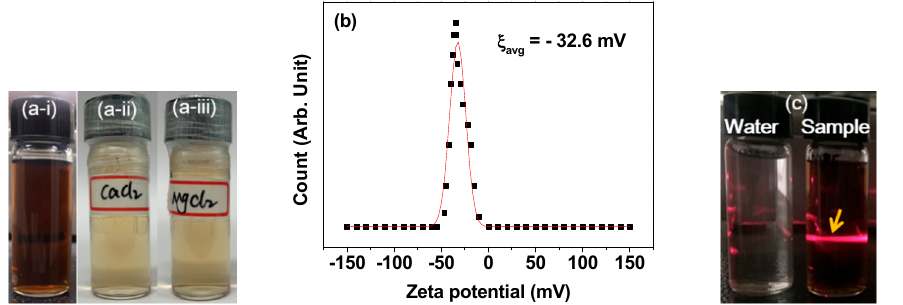
Figure 3. Photographs of ( a-i ) an aqueous nanoparticle dispersion sample (since preparation, no nanoparticle precipitation was observed for >1 year, proving the good nanoparticle colloidal stability) and those of dilute aqueous nanoparticle dispersion samples in the presence of 1.0 mM ( a-ii ) Ca 2+ and ( a-iii ) Mg 2+ ions (no nanoparticle precipitation occurred for 5 days, indicating no effects of these ions on the nanoparticle colloidal stability). ( b ) Zeta potential curve. ( c ) Tyndall effect showing laser light scattering through a laser path (labeled with an arrow) for the aqueous nanoparticle dispersion sample (right vial), whereas no such effect was observed in the triple-distilled water (left vial), confirming the colloidal dispersion. Table 1. Summarized properties of the FA-PAA-coated MnO nanoparticles.